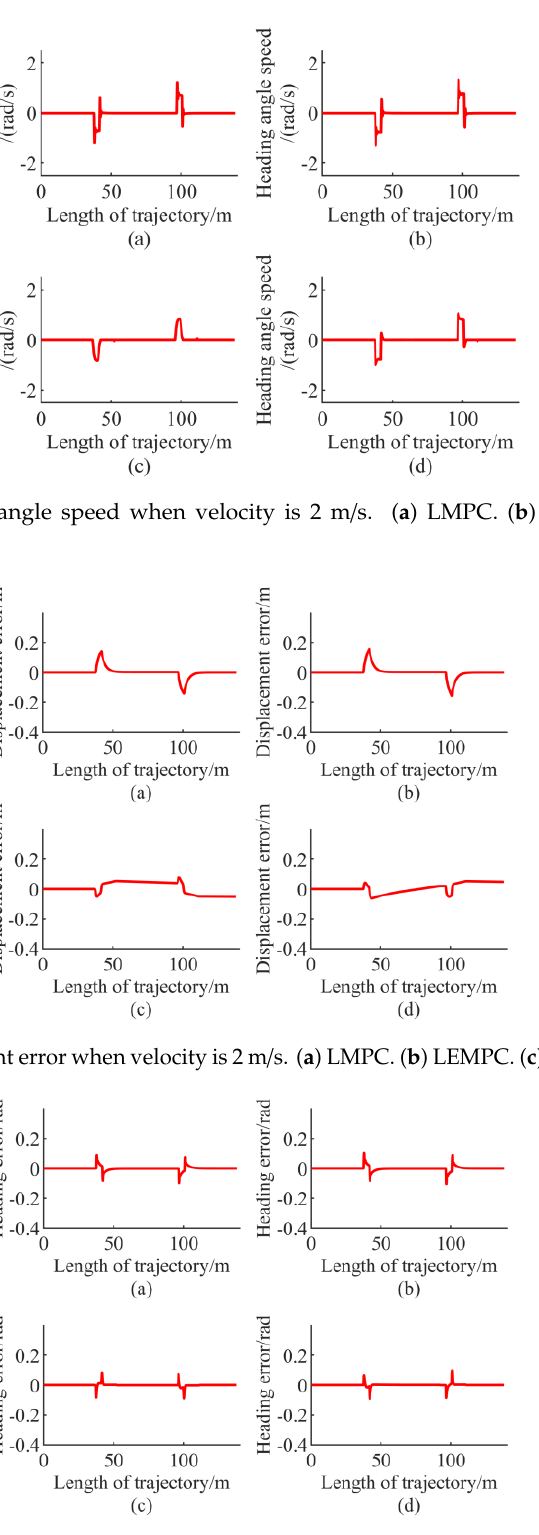
Figure 6. The computation time when velocity is 2 m/s. ( a ) LMPC. ( b ) LEMPC. ( c ) NMPC. ( d ) NEMPC.